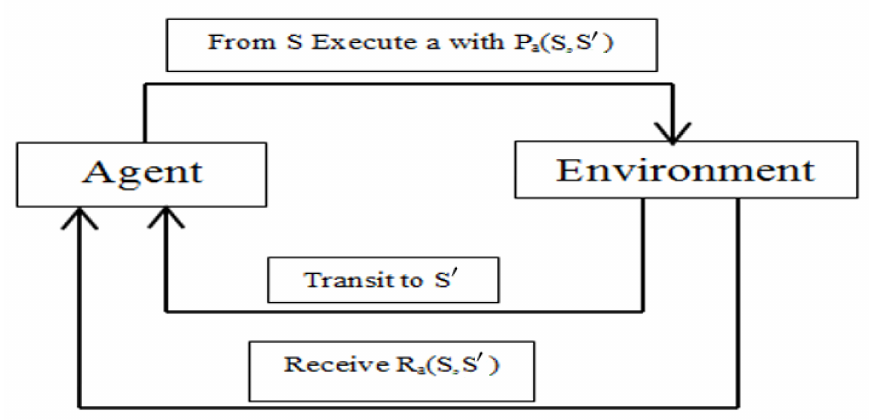
Figure 7. Abstract MDP